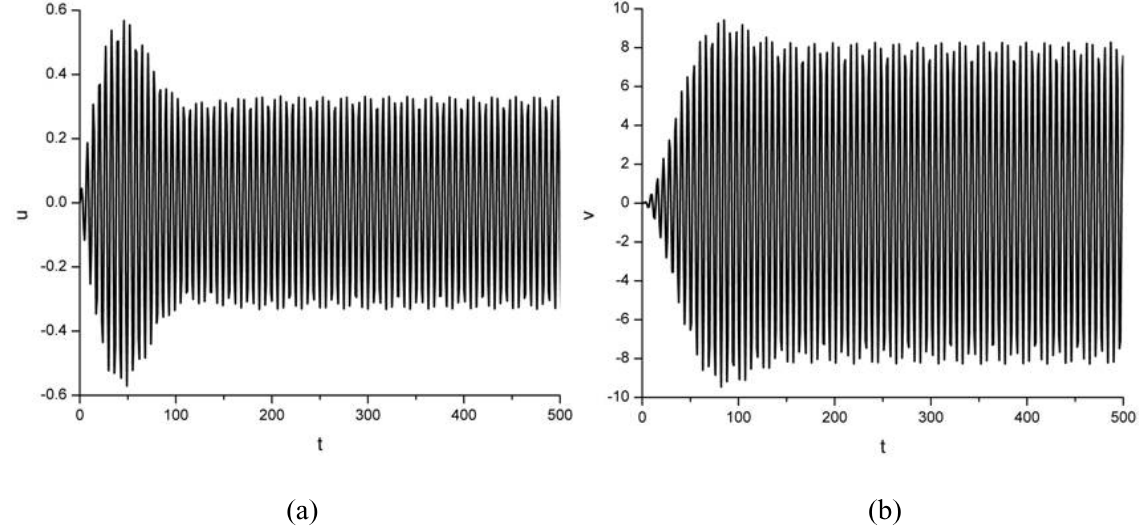
Fig. 16. Numerical simulation of the time response of (a) the plant and (b) the absorber when ω 2 = 1 . 0 , Ω = 1 . 0 and G = 0 . 002 .